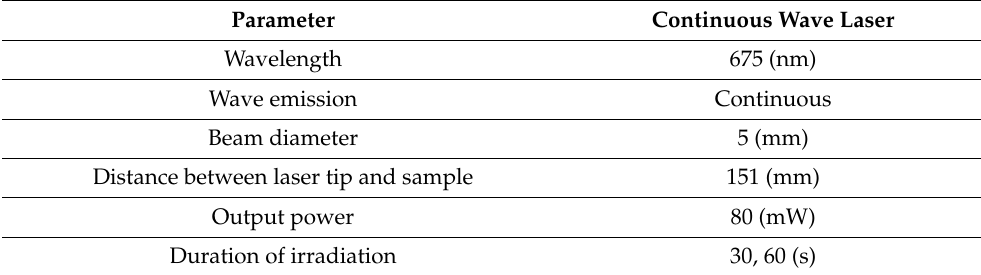
Table 2. The parameters of laser used in this study. Parameter Continuous Wave Laser